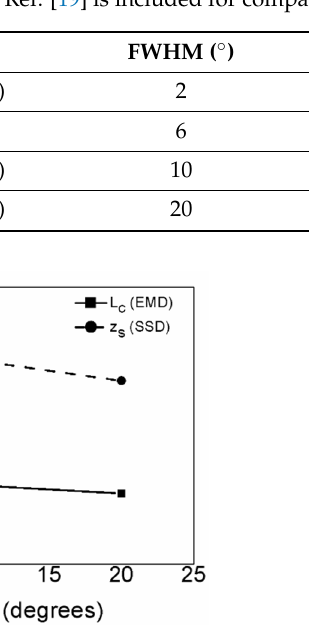
Figure 3. Coupling length L c for achieving the EMD and length z s for establishing an SSD in each of seven carrier cores of MC PCSF for different FWHM of the launch beam distribution.